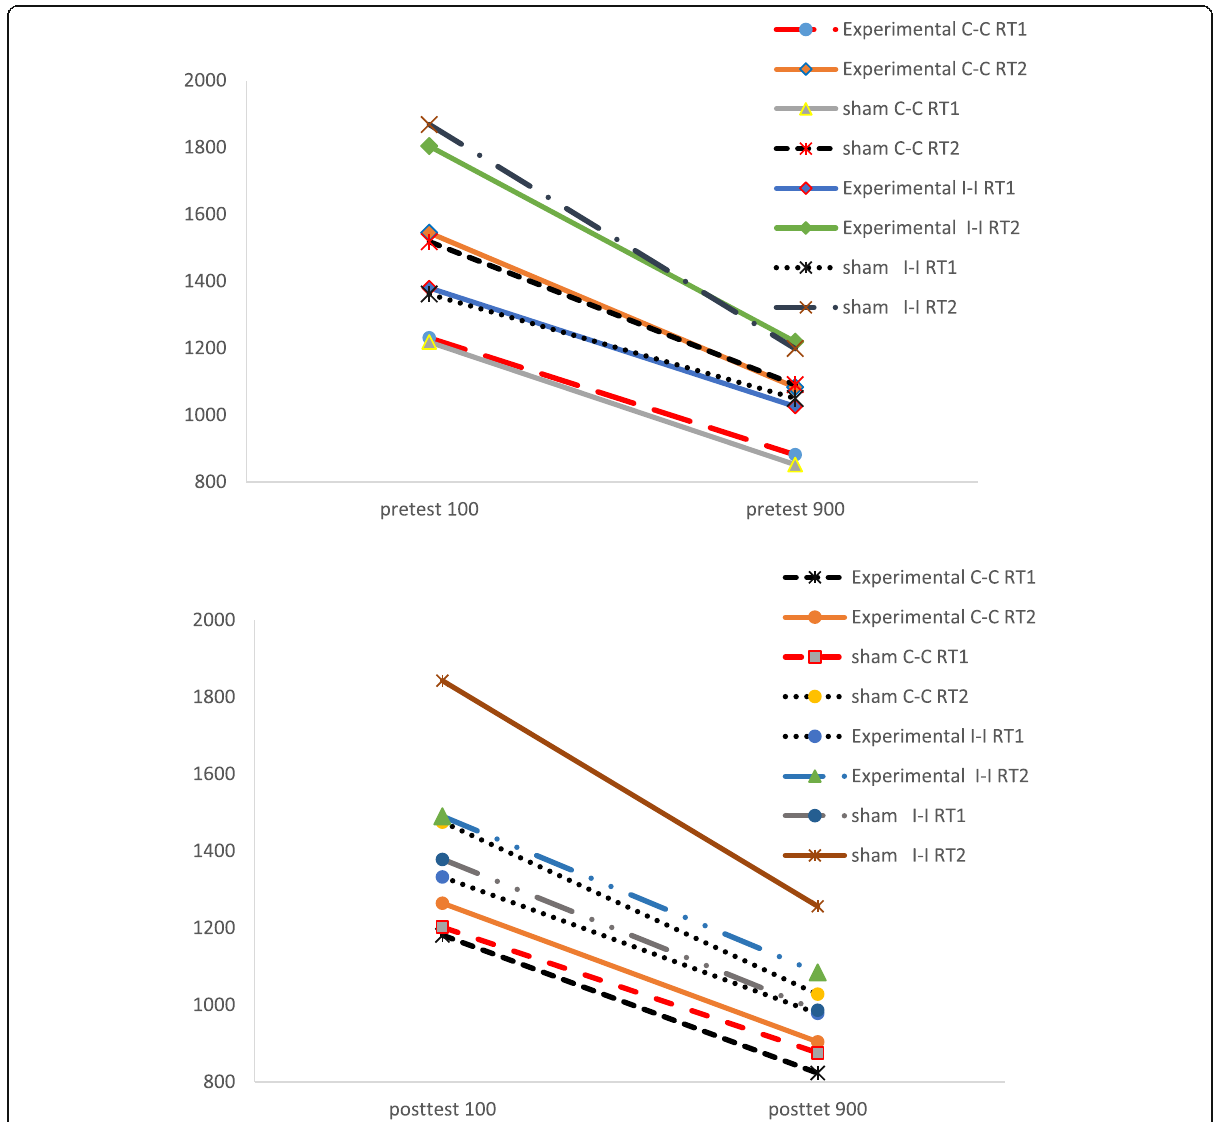
Fig. 3 The means of RT1 and RT2 in the sham and experimental groups for each the pre-test (up) and post-test (down). C-C, congruent-congruent; I-I, incongruent-incongruent; RT1, first reaction time; RT2, second reaction